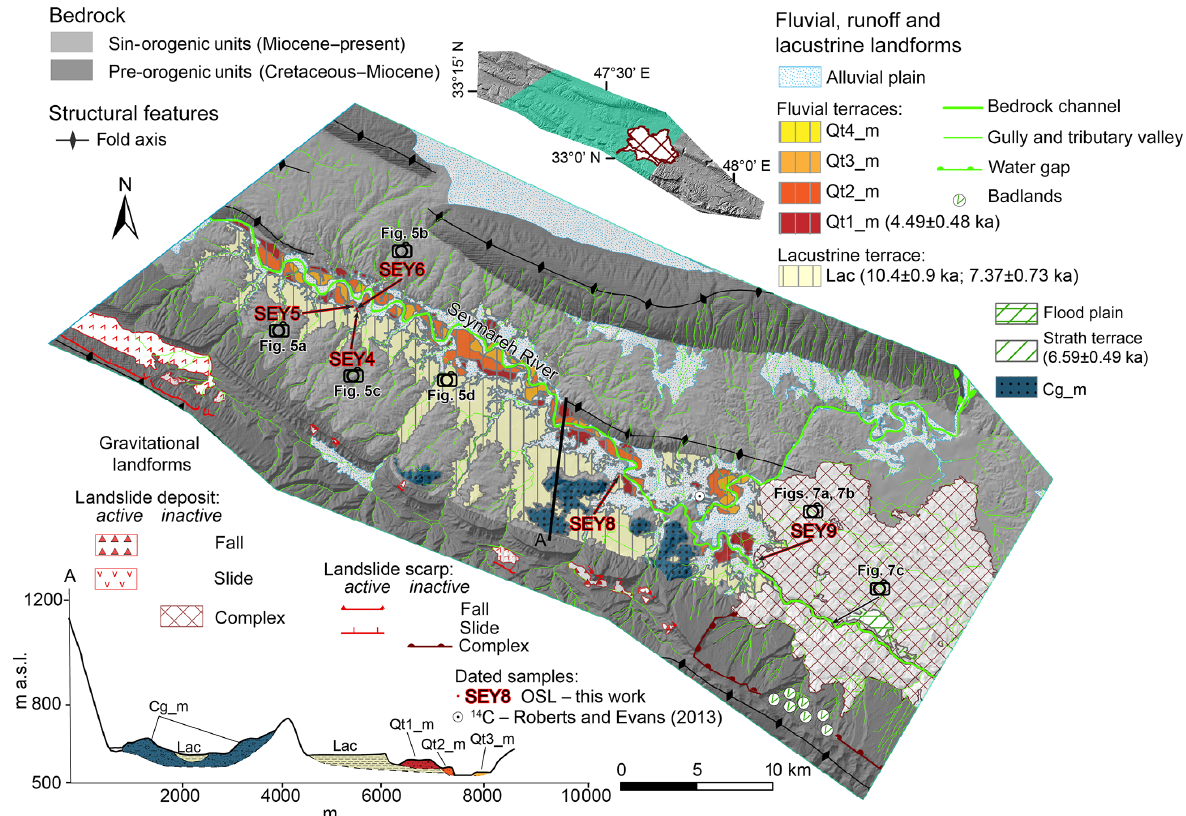
Figure 6. Map of the lacustrine and alluvial terrace suite and of the most significant landforms for the valley slope evolution upstream of the Seymareh